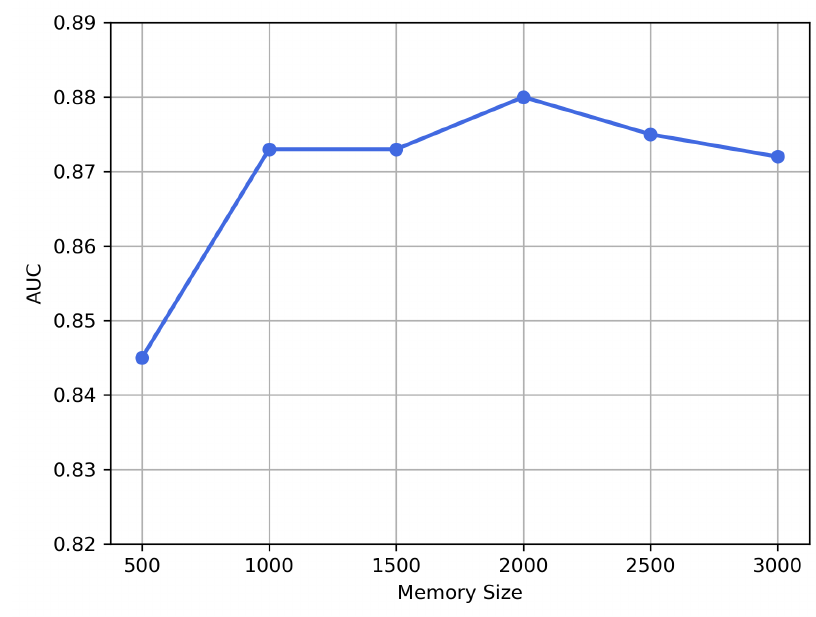
Figure 10. Impact of the size of memory on AUC.